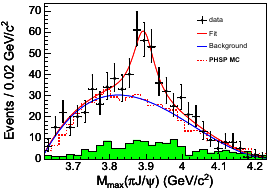
Figure 6. The M max ( π ± J /ψ ) distribution and best fit from BESIII.